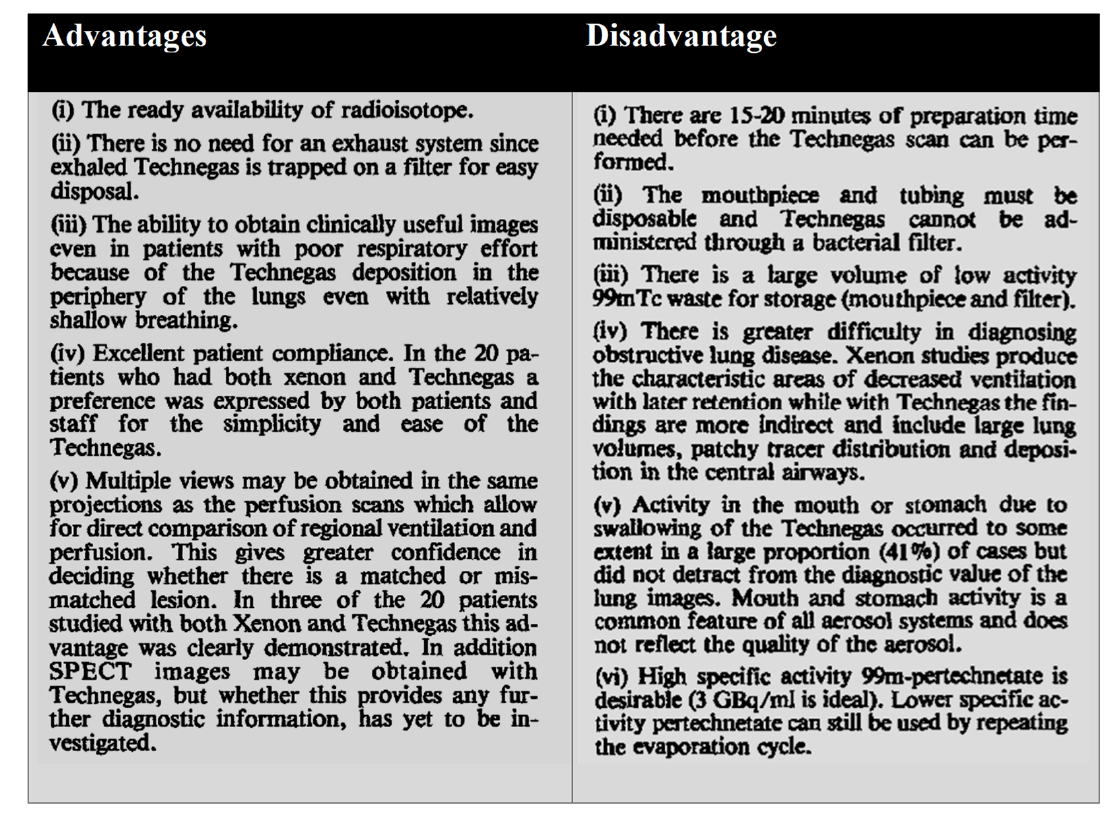
Figure 13. Advantages and disadvantages of Technegas compared to xenon scans. Reprinted/adapted with permission from Ref. [ 9 ]. 1988, John Wiley and Sons.